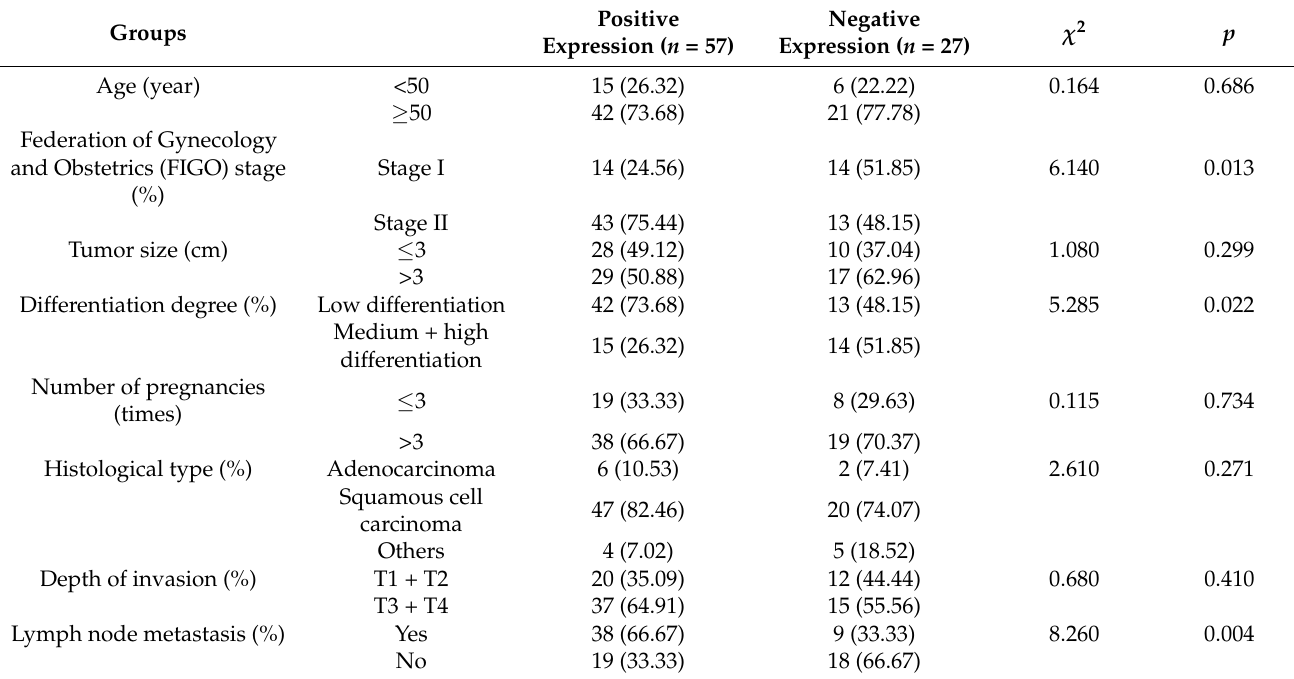
Table 2. The relationship between expression of INHBA and clinicopathological features in CC (cases (%)).